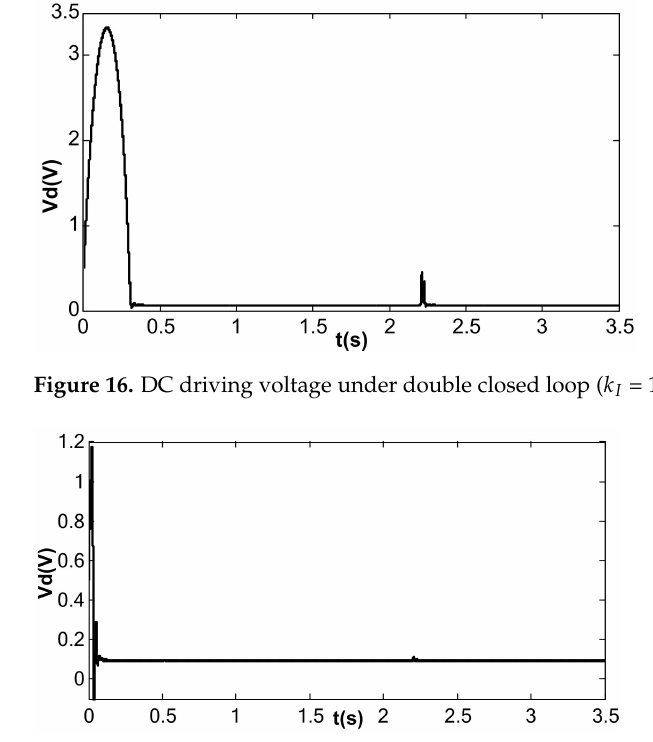
Figure 17. Amplitude fluctuation under double closed loop ( k I = 100, k II = 60).